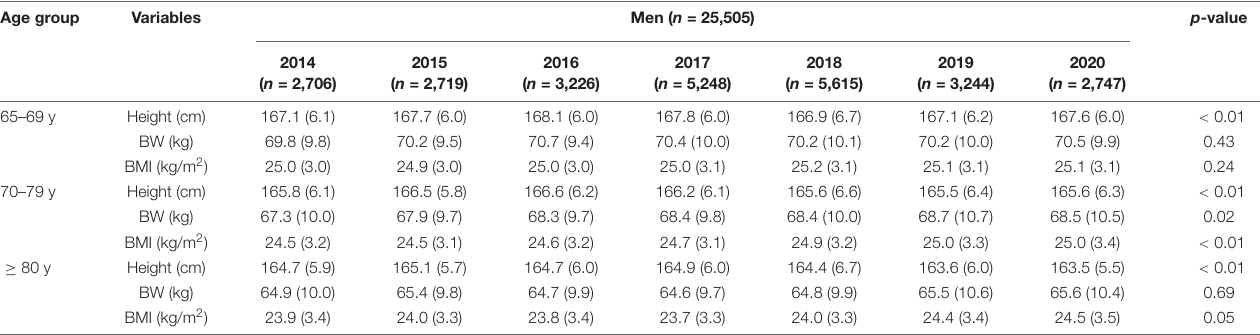
TABLE 1A | General characteristics of 25,505 Chinese aged men from 2014 to 2020. Age group